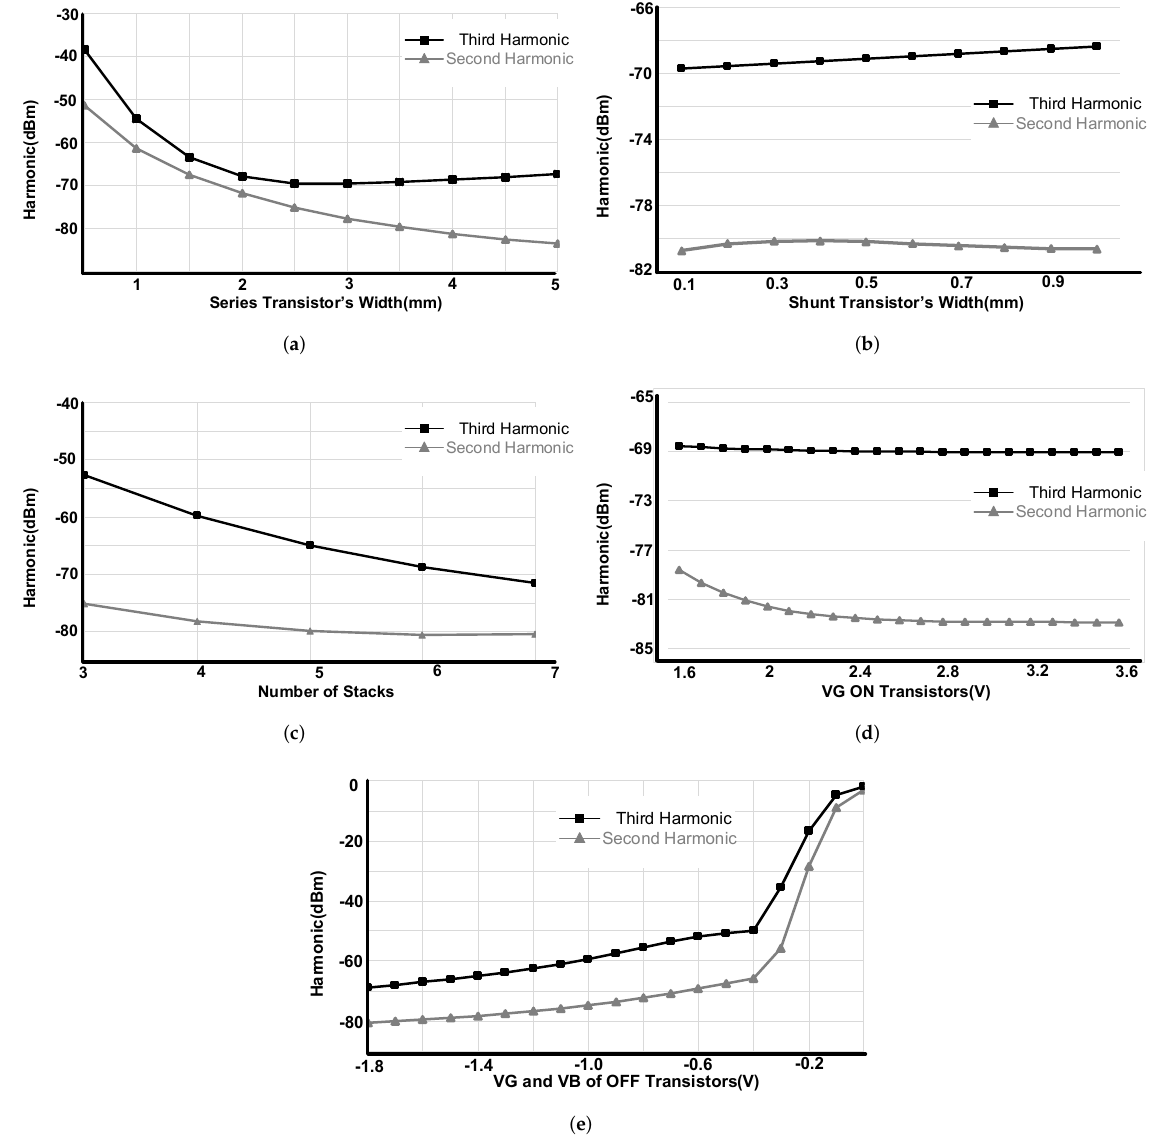
Figure 7. H2 and H3 variation vs. ( a ) series transistors width, ( b ) shunt transistors width, ( c ) number of stacks, ( d ) ON transistors gate voltage and ( e ) OFF transistors gate and body